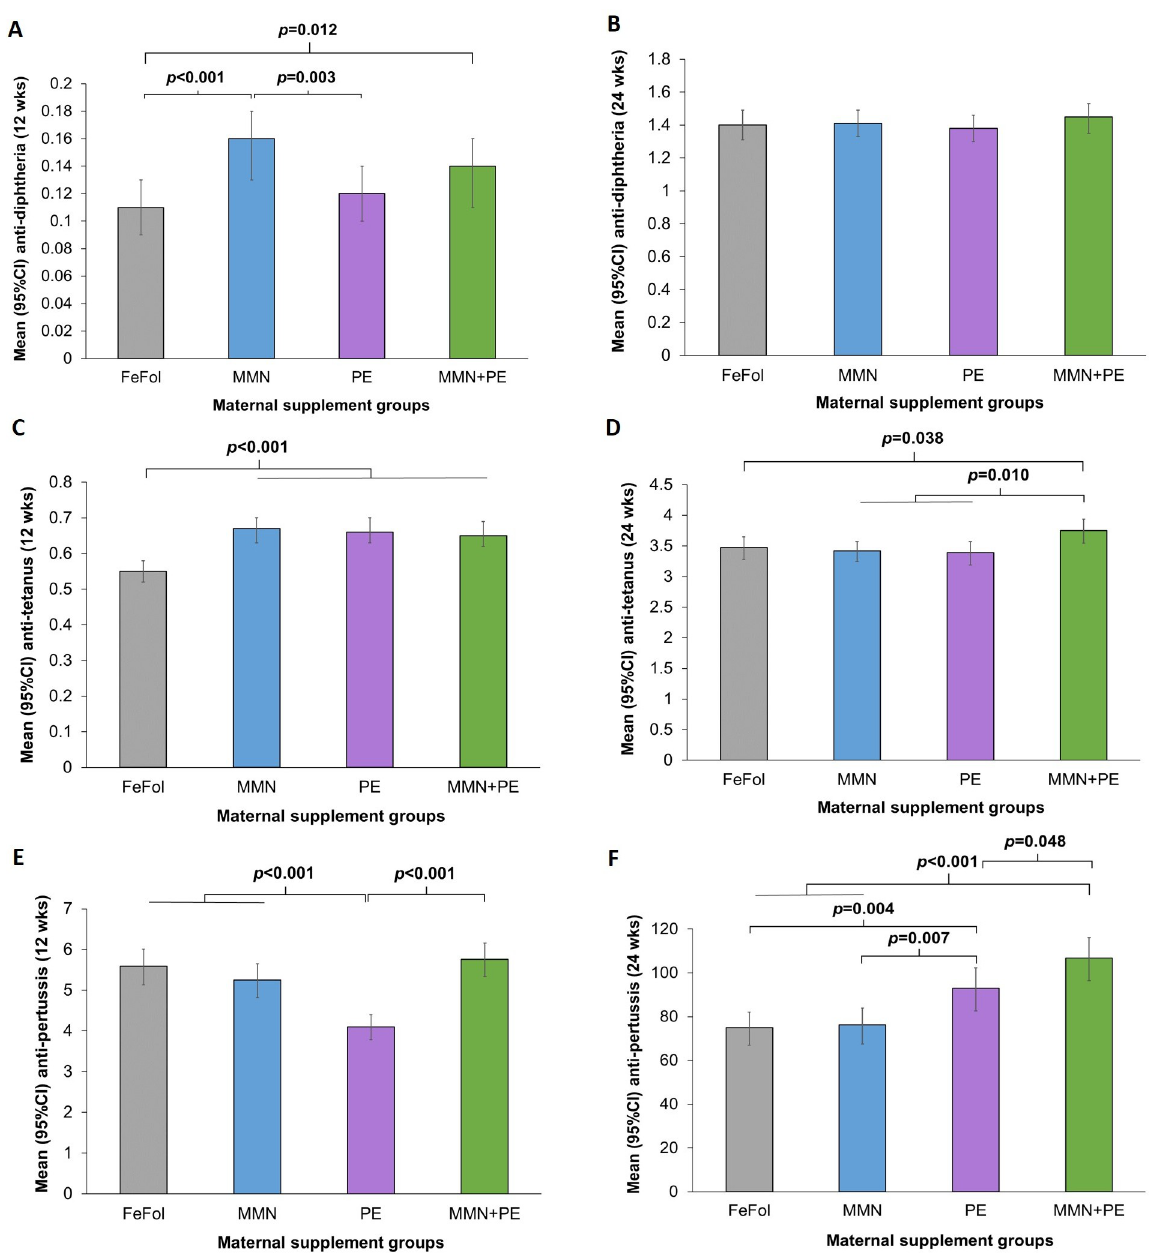
Fig 2. Mean diphtheria, tetanus, and pertussis antibody titres in infants at 12 and 24 weeks of age following the first and third DTP vaccination, by maternal supplement groups. Antibody concentrations were log transformed and, for reporting, mean values and 95% CI were back-transformed from the logarithm scale and expressed in IU/mL for diphtheria and tetanus antibody titres and in EU/mL for pertussis antibody titres. In (A), (C), and (E), means were adjusted with maternal variables: supplement group, compliance to supplement, age, Hb levels at 30 weeks’ gestation, formal education (yes/no), morbidity, and BMI; and with infant variables: GA at delivery, sex, WLZ at first vaccination, Hb levels at 12 weeks, morbidity, EBF (yes/no), birth season (dry/rainy), and Fourier terms of month of the first vaccination. In (B), (D), and (F), means were adjusted with the same factors mentioned above, with changes for infant WLZ third vaccination, Hb levels at 24 weeks, morbidity, and EBF (yes/no) from birth to 24 weeks. Student t test was used for comparison between the supplement groups. BMI, body mass index; CI, confidence interval; DTP, diphtheria-tetanus-pertussis; EBF, exclusively breastfed; FeFol, iron-folic acid; GA, gestational age; Hb, haemoglobin; MMN, multiple micronutrients; PE, protein-energy; WLZ, weight-for-length-z-score.